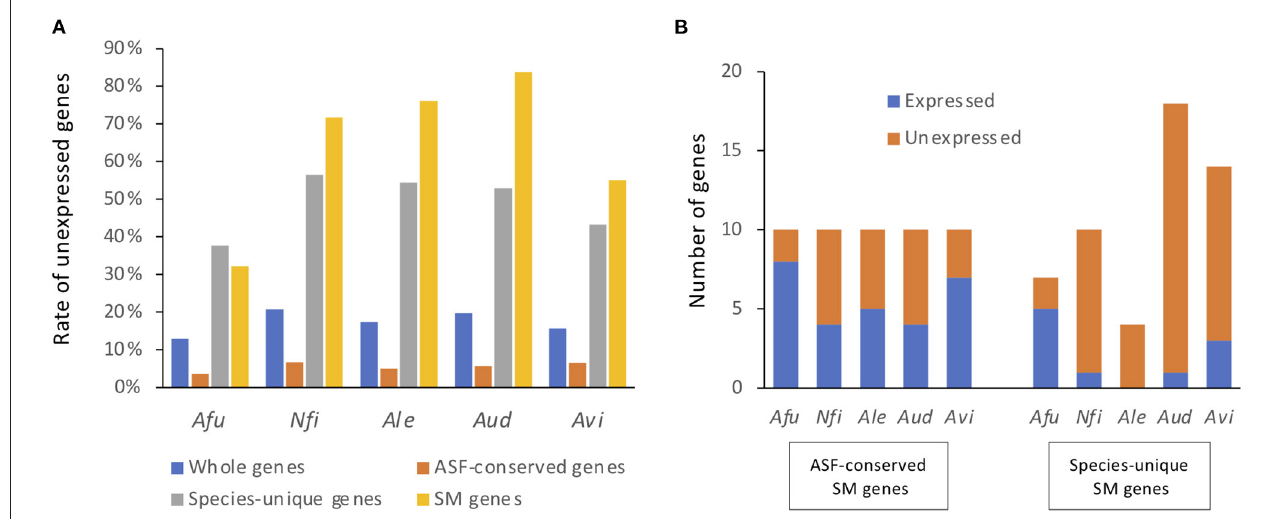
FIGURE 4 | Proportions and numbers of unexpressed SM backbone genes. Genes with TPMs > 5% of the mean TPM in either condition were regarded as expressed genes, whereas the remainder were regarded as unexpressed genes. (A) The proportion of genes that were not expressed in any culture condition are shown for all genes, ASF-conserved genes, species-unique genes, and SM backbone genes. Afu, A. fumigatus; Nfi, N. fischeri; Ale, A. lentulus; Aud, A. udagawae; Avi, A. viridinutans . (B) The numbers of SM backbone genes that were expressed and not expressed in any culture